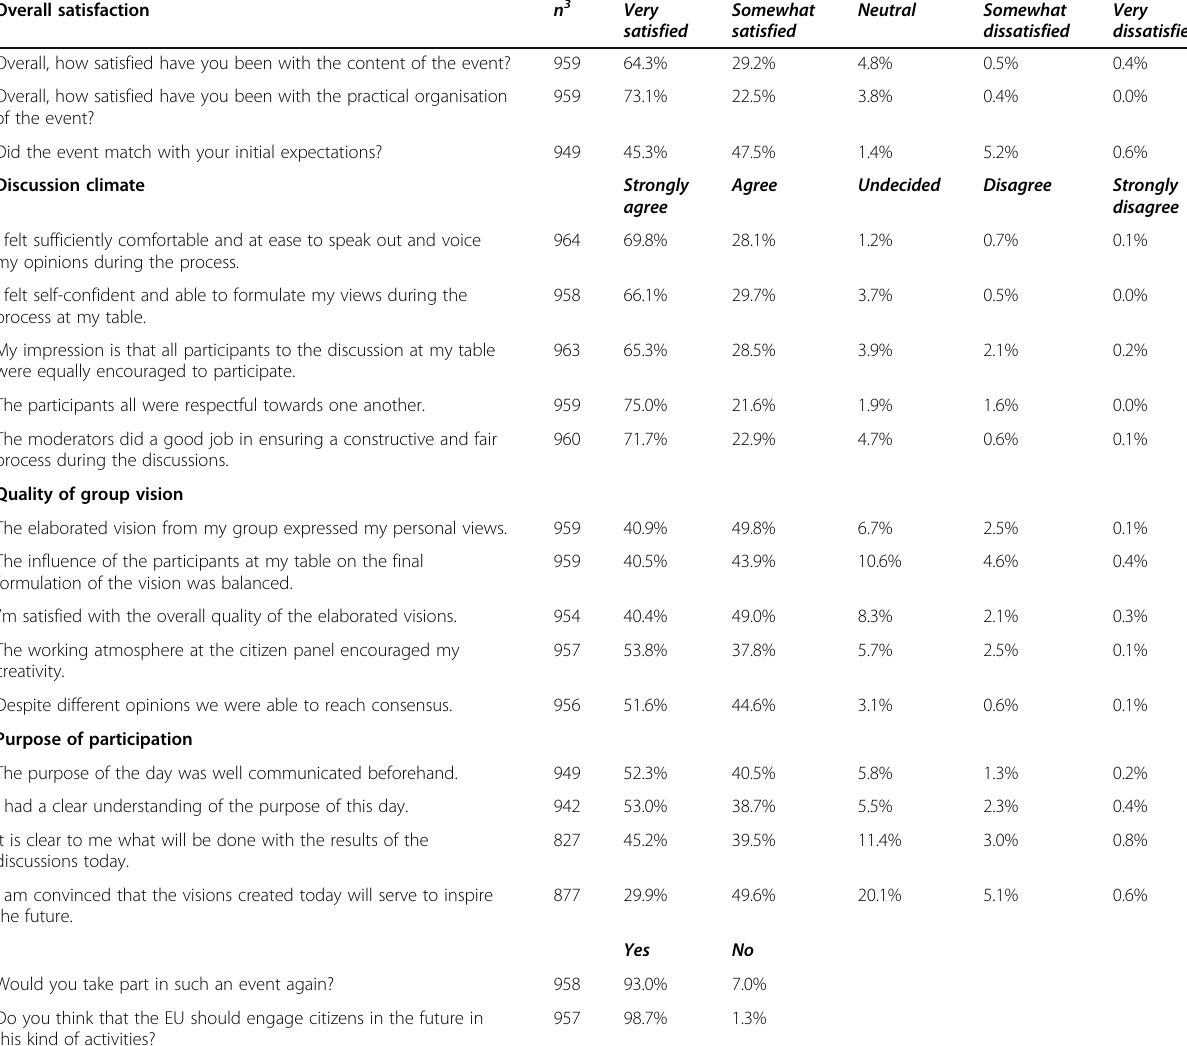
Table 1 Overview of results from participants ’ evaluation of visioning workshop ( n ≈ 964) Overall satisfaction n 3